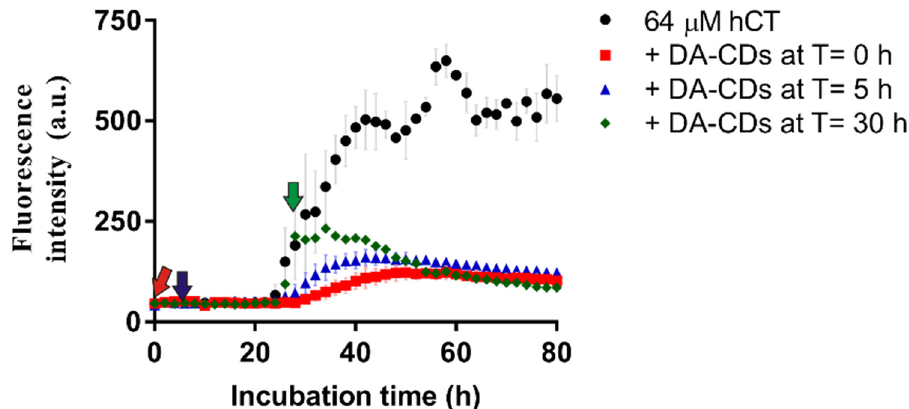
Figure 5. hCT aggregation kinetics monitored by ThT assay. DA-CDs were added at different time points during the aggregation process. Red arrow: 0 h; blue arrow: 5 h; green arrow: 30 h.